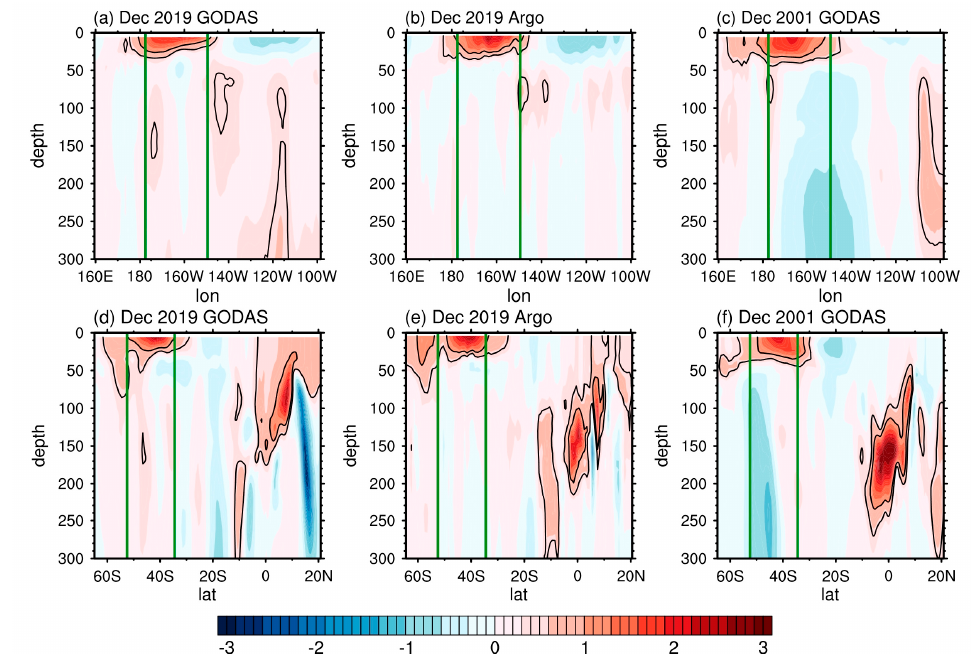
Figure 2. The depth-longitude vertical section of subsurface temperature anomalies (shading and contour, 0.5 °C and 1.0 °C highlighted) averaged over 34° S–52° S in ( a ) December 2019 using GODAS data, ( b ) December 2019 using Argo data, and ( c ) December 2001 using GODAS data, respectively. ( d – f ) Same as ( a – c ), but for depth-latitude section averaged over 150° W–178° W. The green vertical lines outline the blob area.